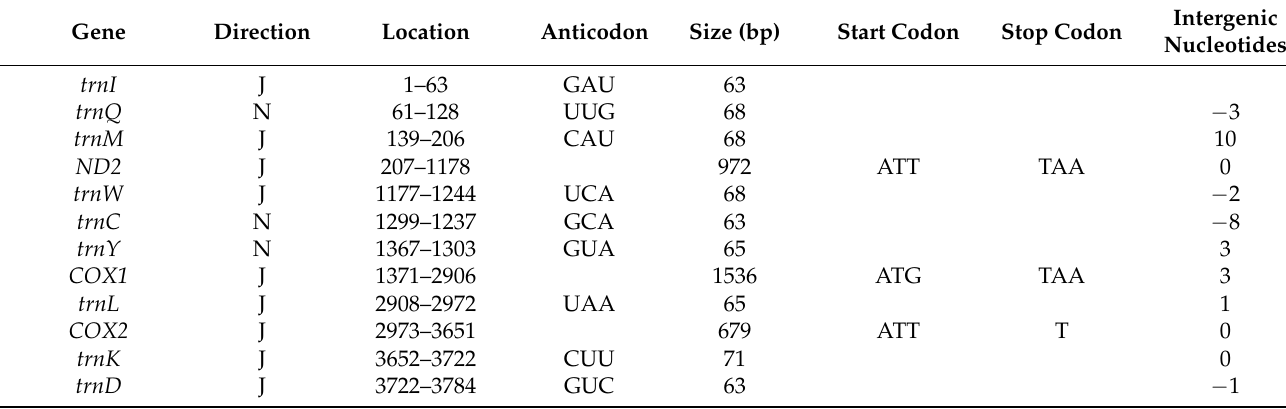
Table 3. Annotations for the Atkinsoniella xanthonota mitochondrial